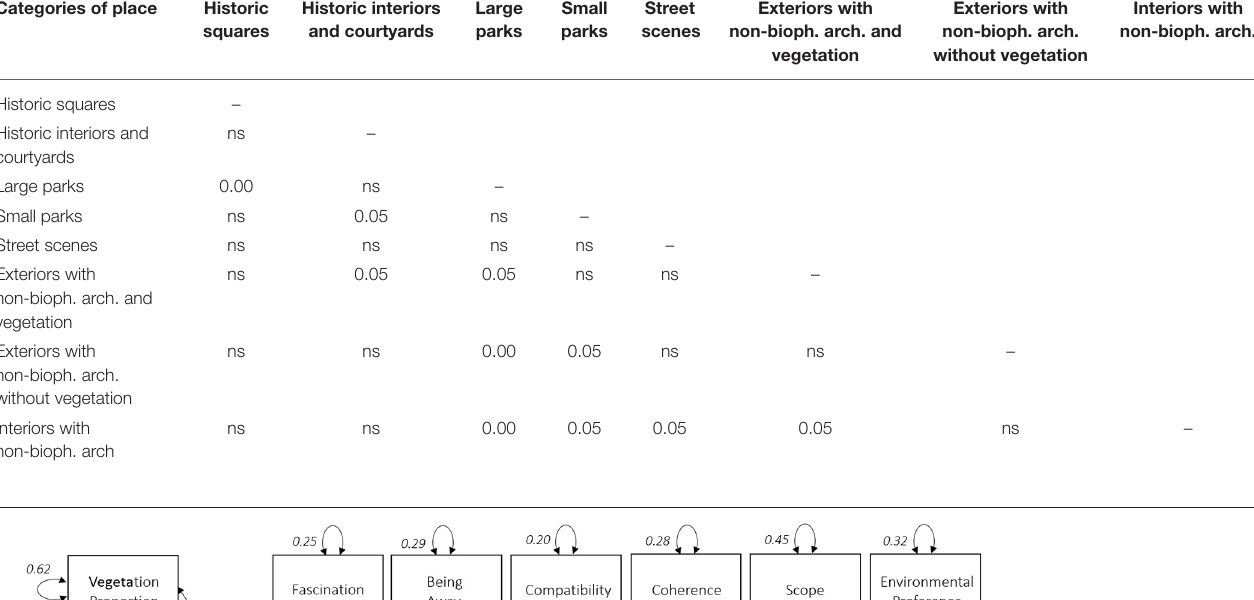
TABLE 6 | Comparisons of noise scores across the places ( N = 470, pairwise comparison p -values). Categories of place